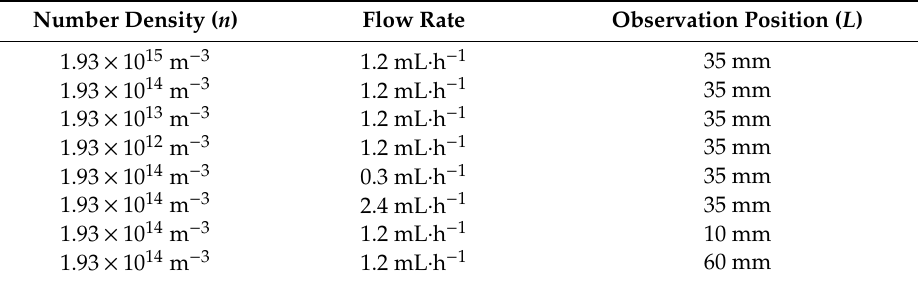
Figure 3. Image for fluorescent biotinylated Polystyrene (PS) bead bound to streptavidin on the surface of the micro-channel ( a ) from fluorescent microscopy ( b ) after image processing for counting the bound beads.